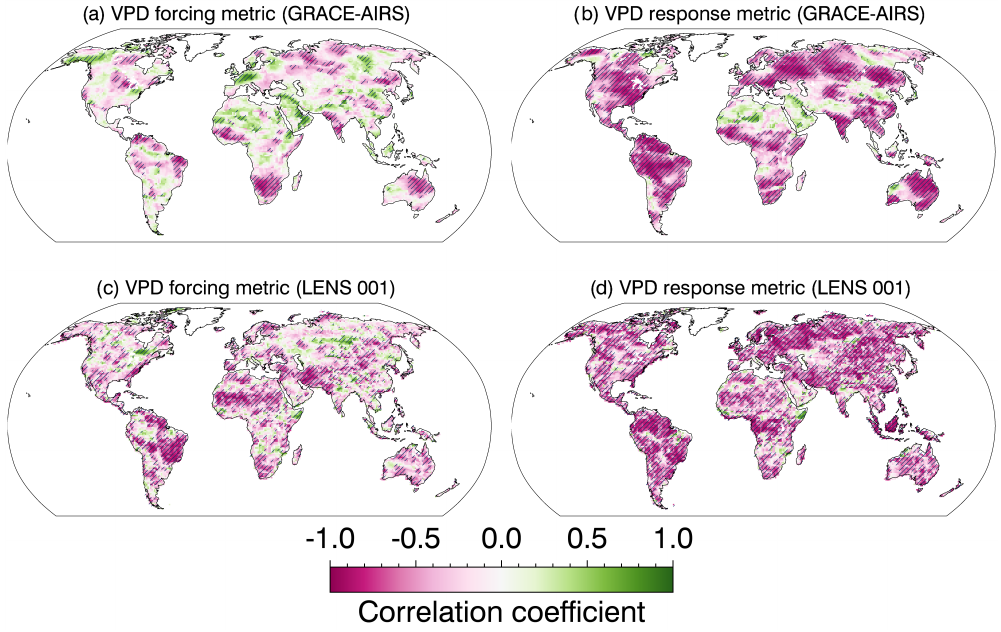
Figure 5. Forcing and response metrics for VPD from GRACE/AIRS (a, b) and LENS ensemble member 001 (c, d) . Cross-hatching indicates a correlation coefficient that is statistically significant at p ≤